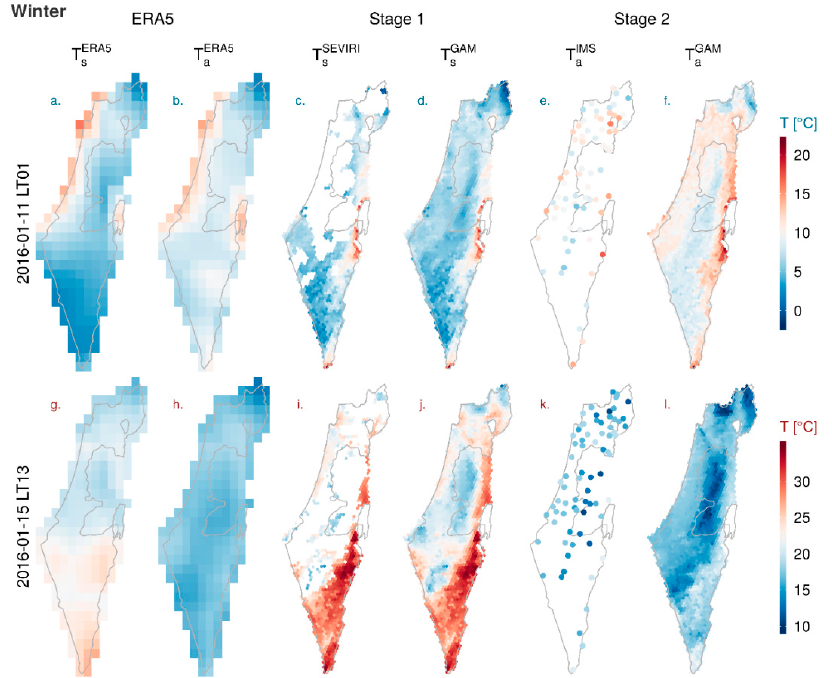
Figure 14. Inputs and outputs of the two-stage model for the nighttime (LT 0100, ( a – f )) and daytime (LT 1300, ( g – l )) hours of a typical winter day (15-01-2016) contrasting baseline input data (Stage 1: Ts, Ta from ERA5, Ts from SEVIRI with gaps; Stage 2: Ta from IMS weather stations), output from Stage 1 (Ts estimated by GAM), and output from Stage 2 (Ta estimated by GAM).